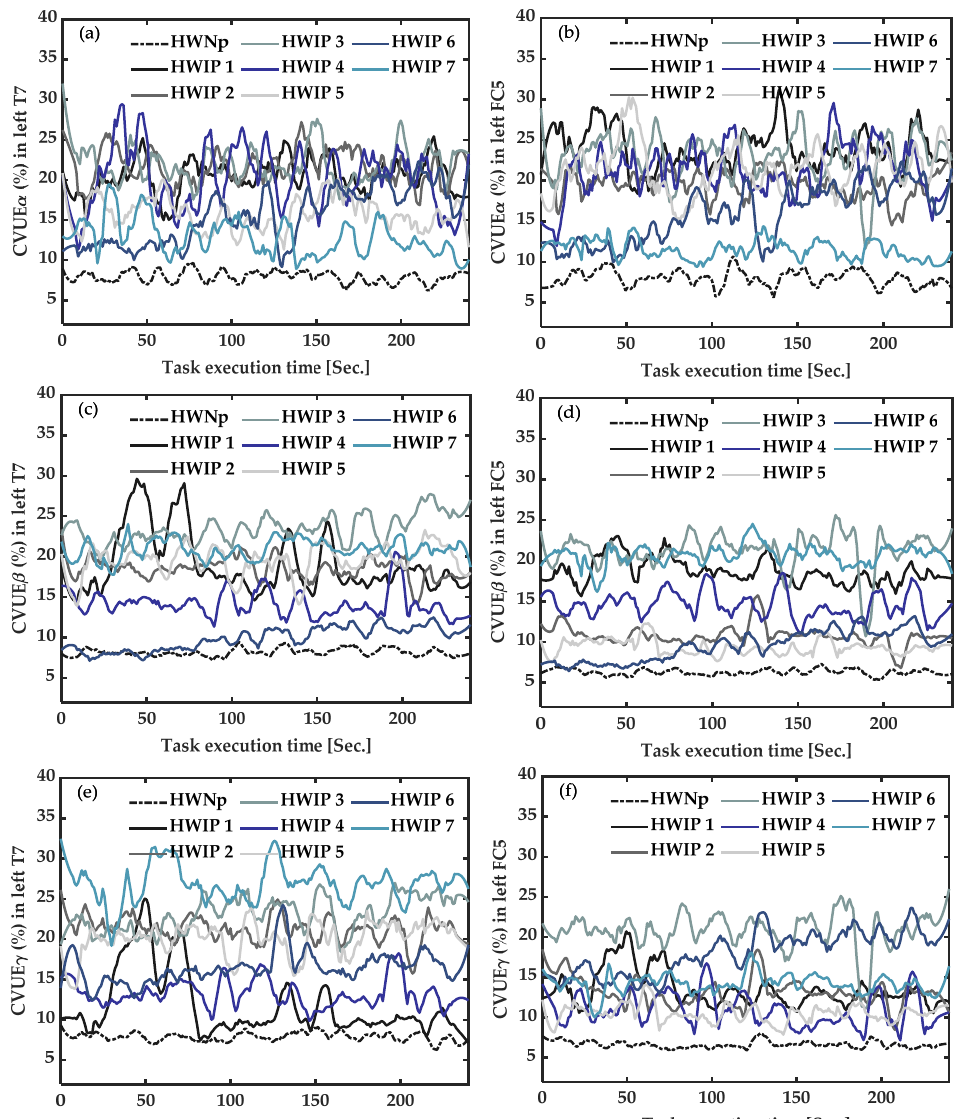
Figure 6. Active measures of the coefficient of variation of upper envelope (CVUE) in alpha (CVUE α ), beta (CVUE β ) and gamma (CVUE γ ), during task execution. ( a )—CVUE α from left temporal (T7) data, ( b )—CVUE α from left fronto-central (FC5) data, ( c )—CVUE β from left temporal (T7) data, ( d )—CVUE β from left fronto-central (FC5) data, ( e )—CVUE γ from left temporal (T7) data, ( f )—CVUE γ from left fronto-central (FC5) data. The black dotted line indicates the average of CVUE of healthy with “No pain” (HWNp). The colored lines represent CVUE of the seven healthy with induced pain (HWIP 1-7 ). The graphs were smoothed by a 15th-order of Savitzky–Golay filter. All CVUE (CVUE α , CVUE β , and CVUE γ ) from left FC5 were higher in